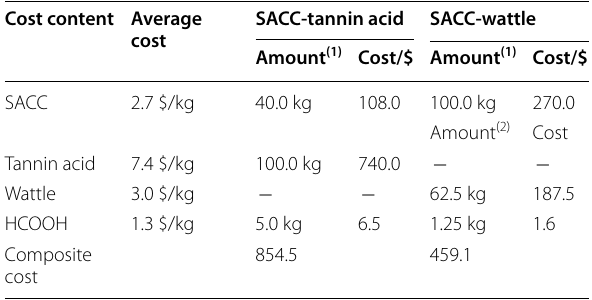
Table 4 The cost of main chemicals used in the SACC-tannin acid and SACC-wattle combination